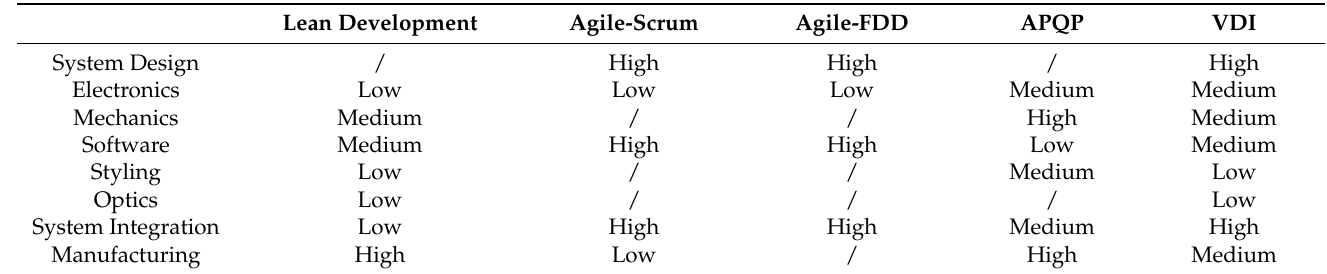
Table 1. Headlights design approach concerning different development life-cycles. Lean